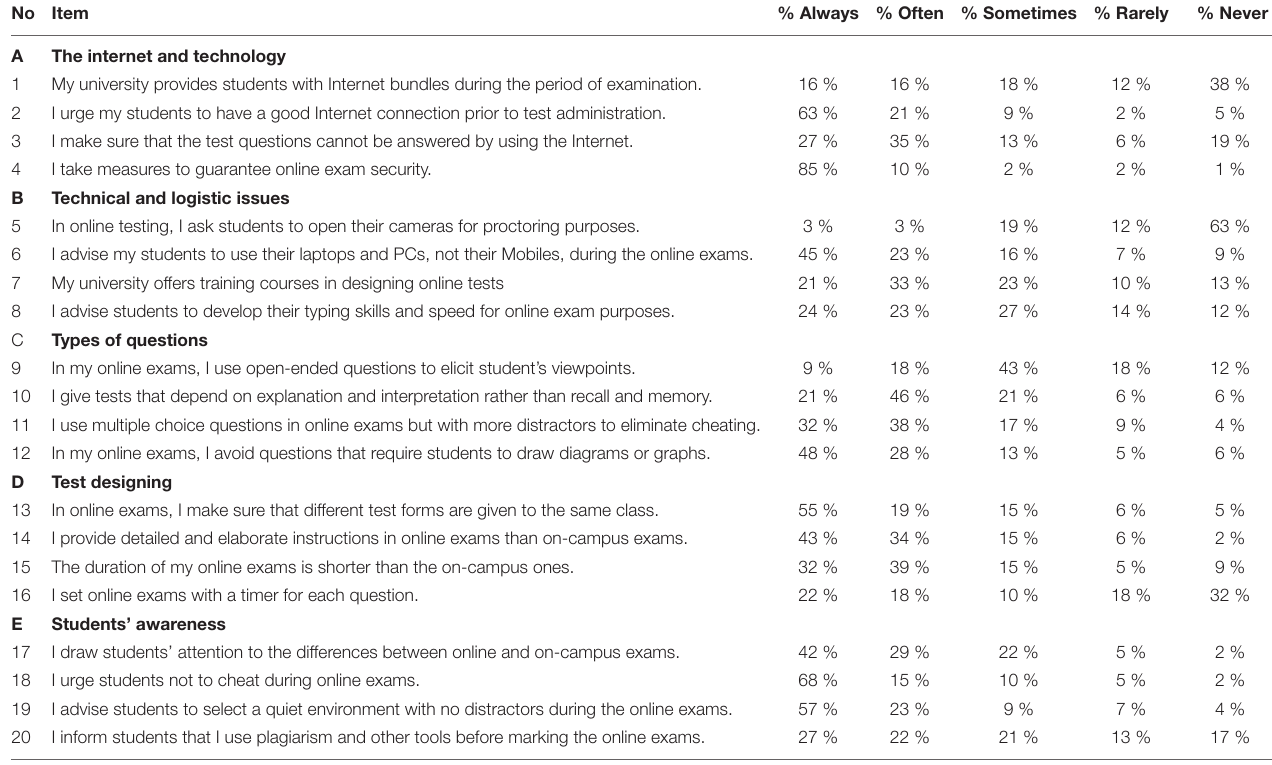
TABLE 3 | Percentage of the instructors’